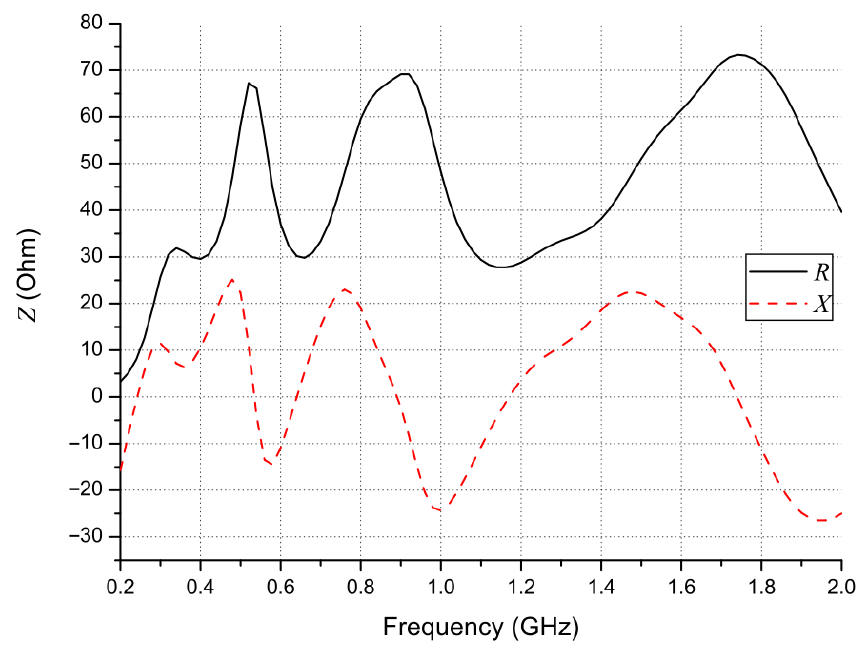
Figure A5. Simulated input impedance of the final antenna